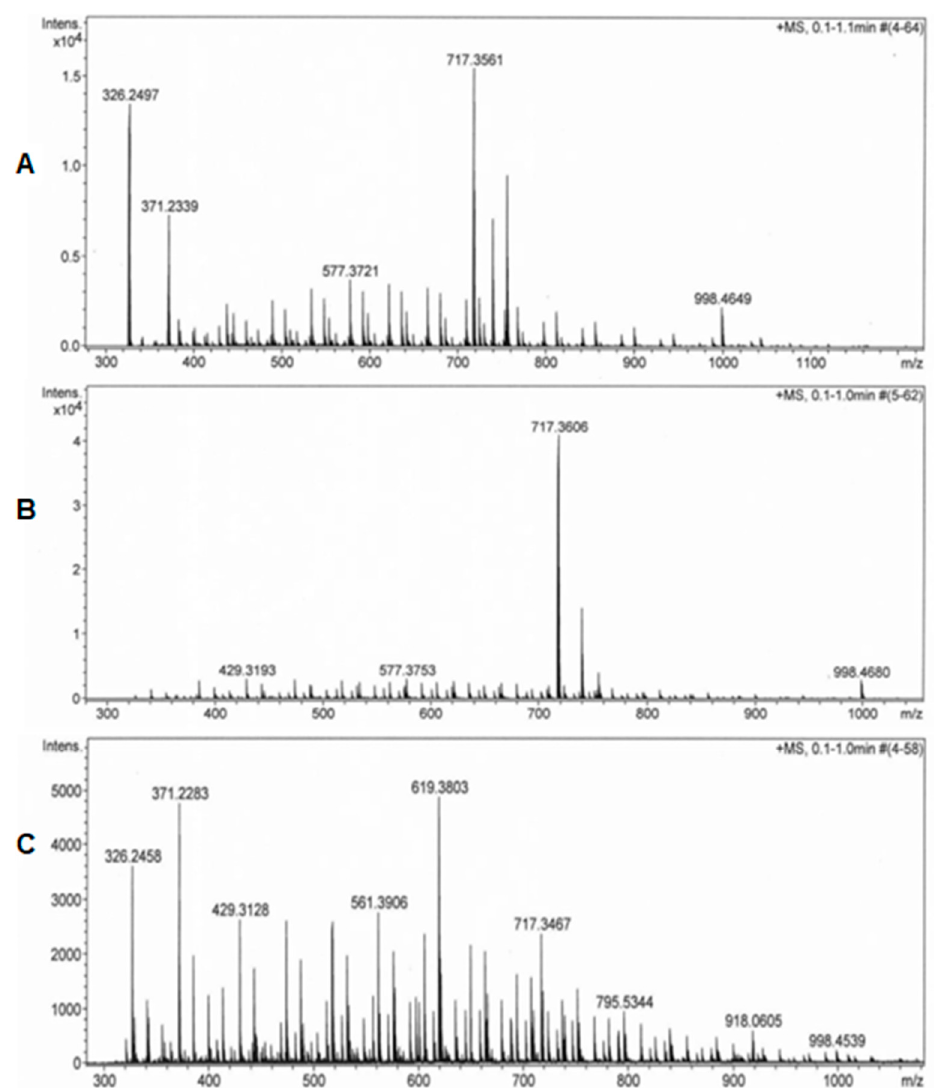
Figure 4. Mass / Mass (MS / MS) fragmentation spectrum of the studied samples as ( A ) a fraction from an undigested and non-encapsulated f4; ( B ) an obtained fraction from the digested SA-AG capsules corresponding to the gastric phase; ( C ) an obtained fraction from the digested SA-AG capsules from the duodenal phase.